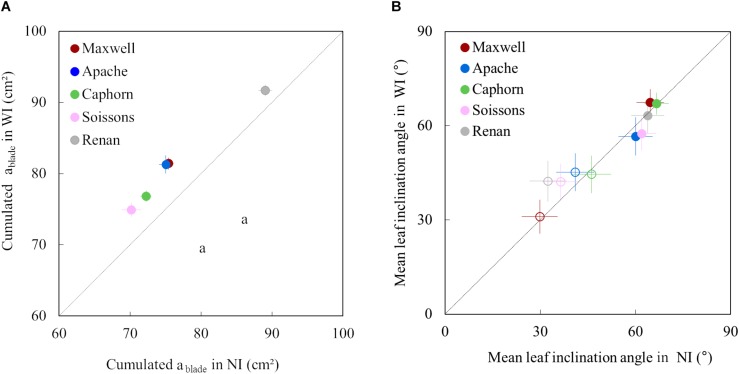
The cumulative area of the four upper blades of the main stem (A) and the mean leaf inclination angle α (B) in WI treatments vs. NI treatments. Each color is associated with a cultivar, as indicated in the legend. The dotted line represents the line 1:1. In (A), symbols represent the mean of values measured on 45 plants per treatment; error bars mark the 95% confidence intervals of the mean estimates. In (B), empty symbols represent measurements at the start of stem extension (722°Cd) while full symbols represent measurements close to ear emergence (1272°Cd); error bars mark the quarter of standard deviation of mean estimates of all triangles representing leaves (to make the figure easier to read).